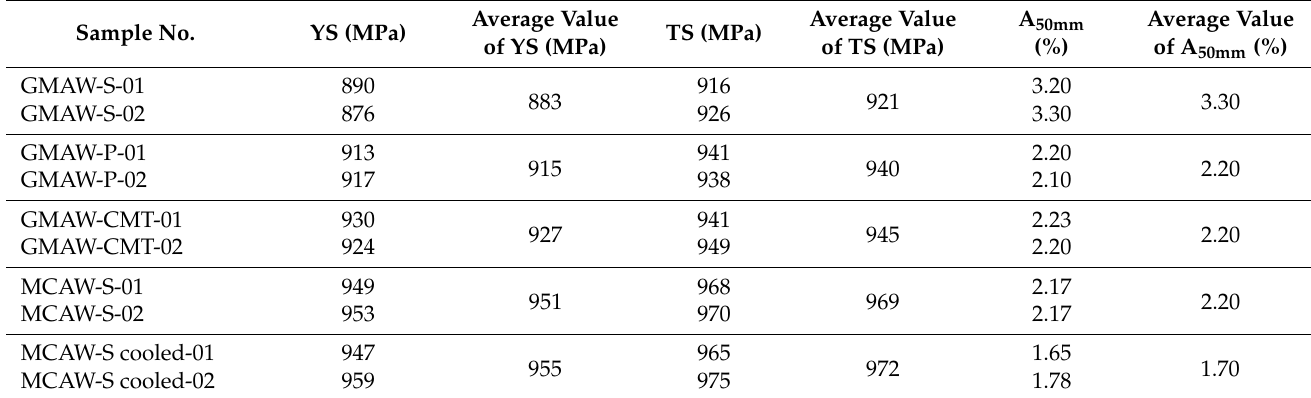
Table 6. Mechanical properties of the evaluated welded joints of S960MC